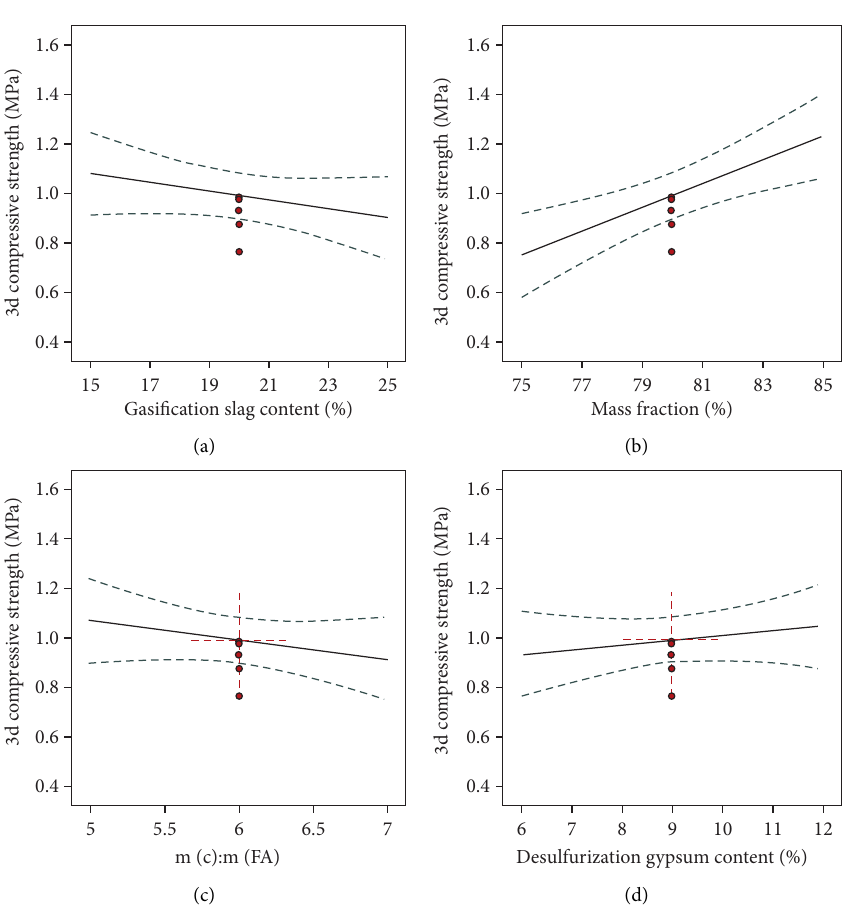
Figure 10: Prediction of single-factor effect on 3d uniaxial compressive strength response surface. (a) X (b) X 2 single-factor impact prediction. (c) X 3 single-factor impact prediction. (d) X 4 single-factor impact prediction.